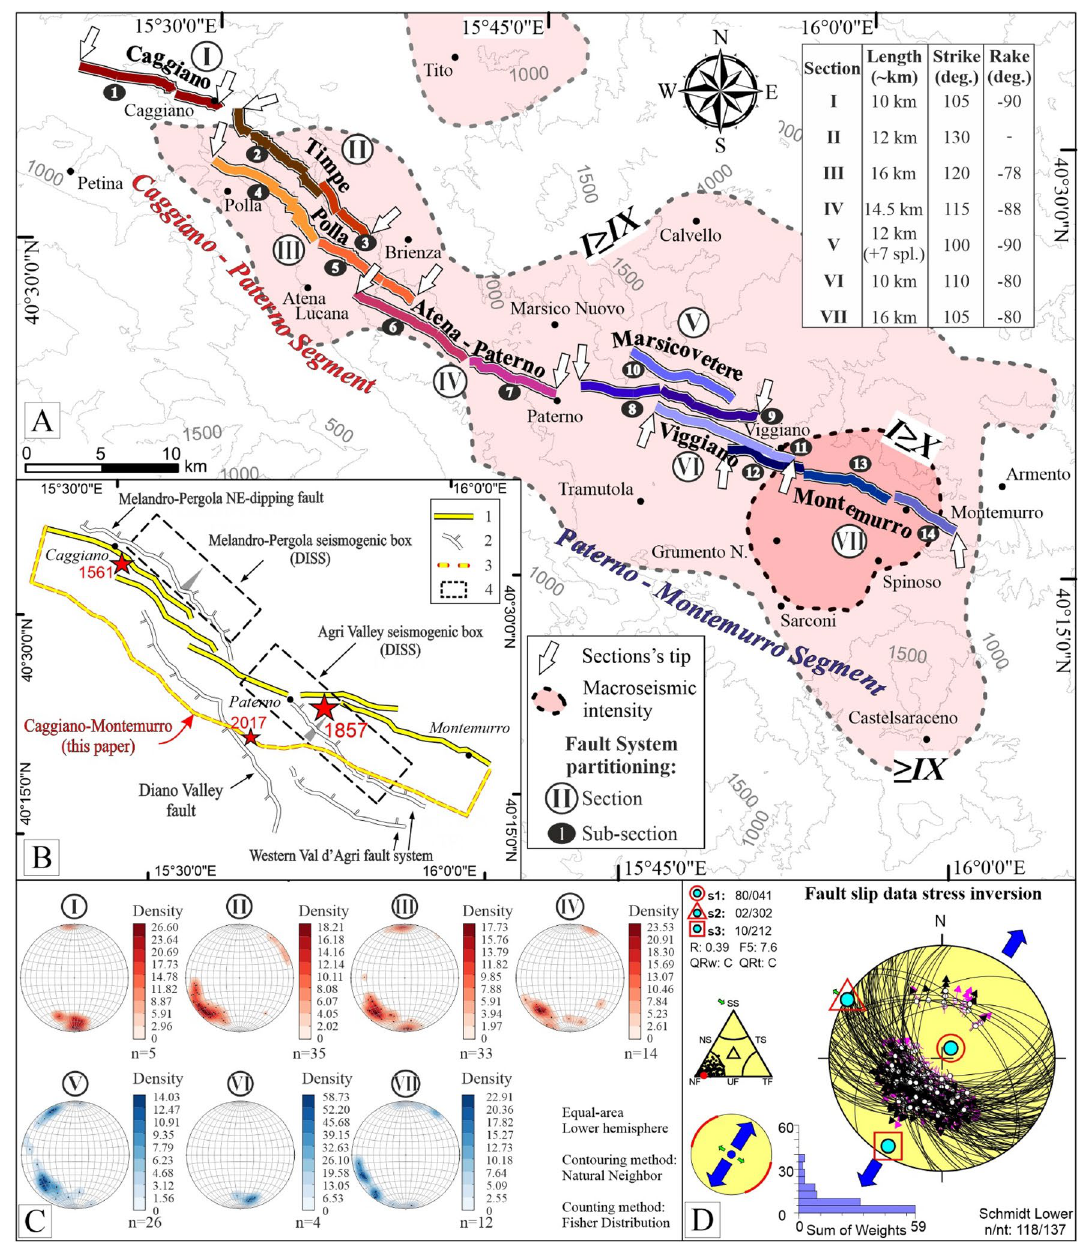
Figure 6. (A) Synthetic representation of the segmentation highlighted in this paper, in the context of the 1857 earthquake and Quaternary stress field. (B) (1) Caggiano-Montemurro Fault System (CMF); (2) Other fault systems from literature with ticks on downthrown side; (3) Surface projection of the inferred depth tip-line obtained enveloping the fault sections and extrapolating it with a constant 60° dip to 12 km depth; (4) Seismogenic boxes from DISS 3 . Red stars are the macroseismic epicenter of the 1857 and 1561 6 , and 2017 11 earthquakes. (C) Results of the kinematic analysis represented in the contour of the T-axis of the deformation in stereoplots. (D) Stress inversion of the structural dataset. Inversion procedure as in Delvaux and Sperner 68 . Histogram = misfit angles vs . number of data points; nt = total number of data; n = number of successfully inverted data; σ1, σ2, σ3 = principal stress axes; R = stress ratio = (σ2 − σ3)/(σ1 − σ3); QR = quality factors as in 69,70